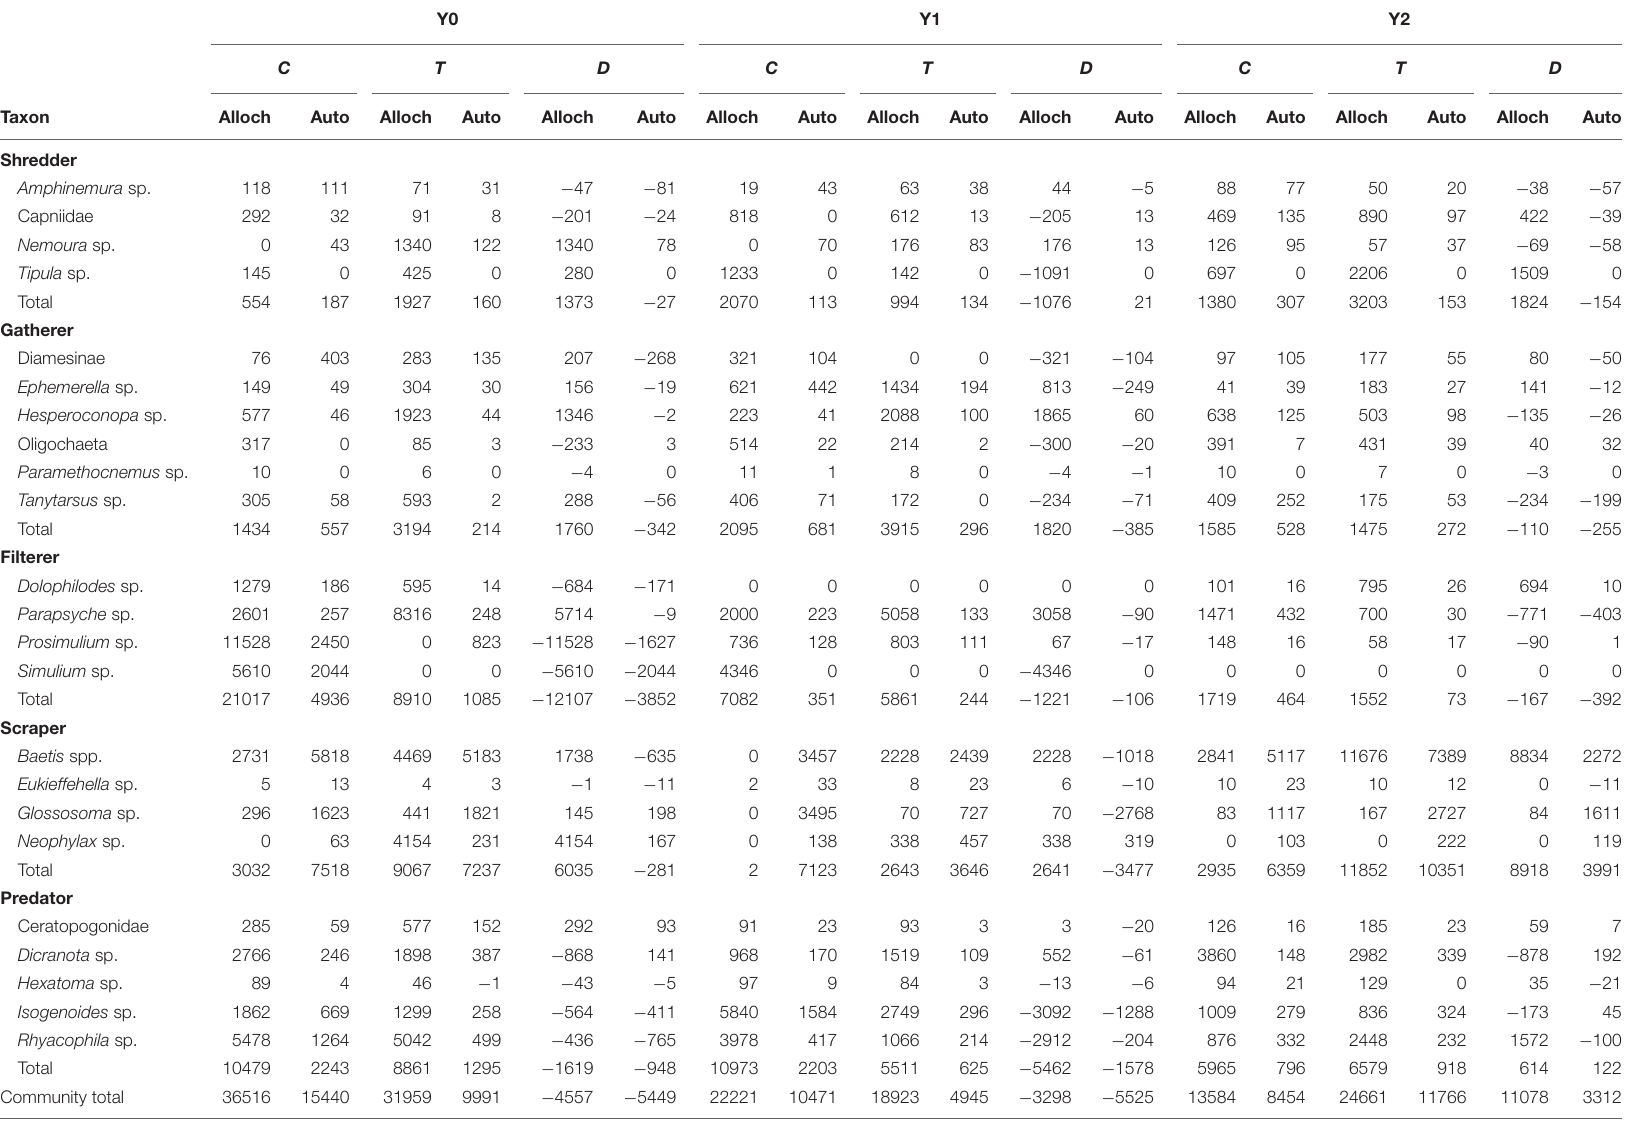
*Indicates a significant change in mean macroinvertebrate δ 13 C value after wood addition. D is the difference in treatment (T) and control (C). B is before (Y0) and A. is after (Y1 and Y2) wood addition. Functional groups are in